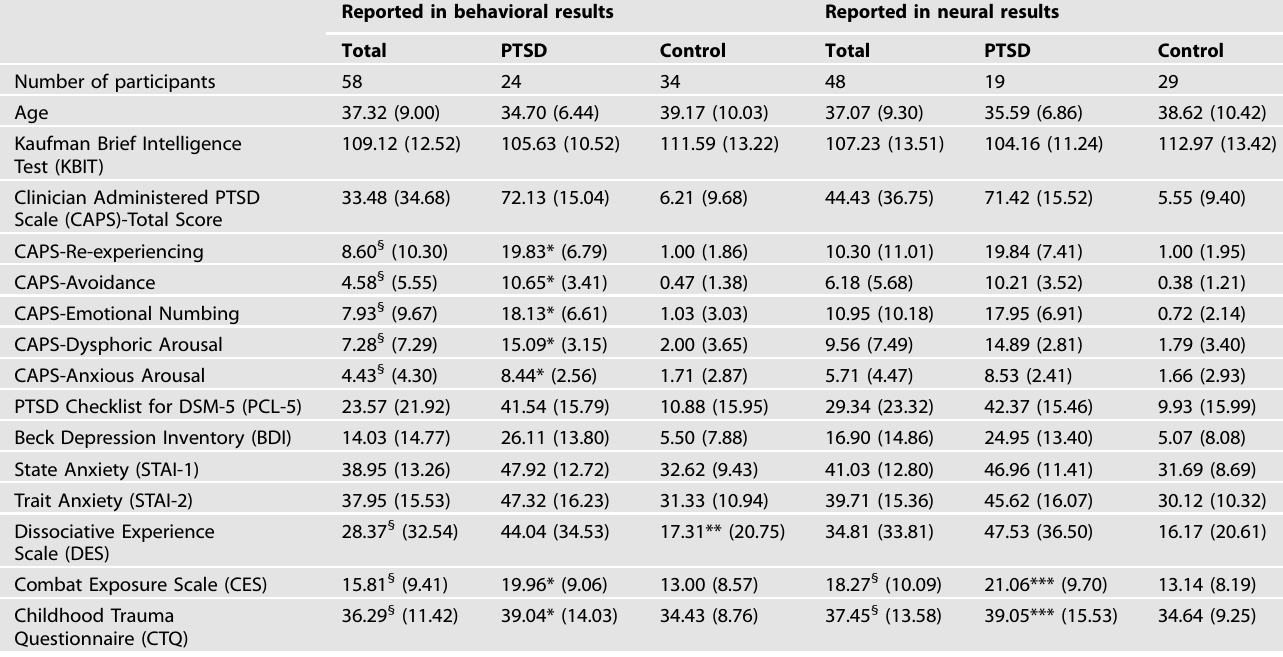
Table 1. Descriptive statistics of demographics and clinical